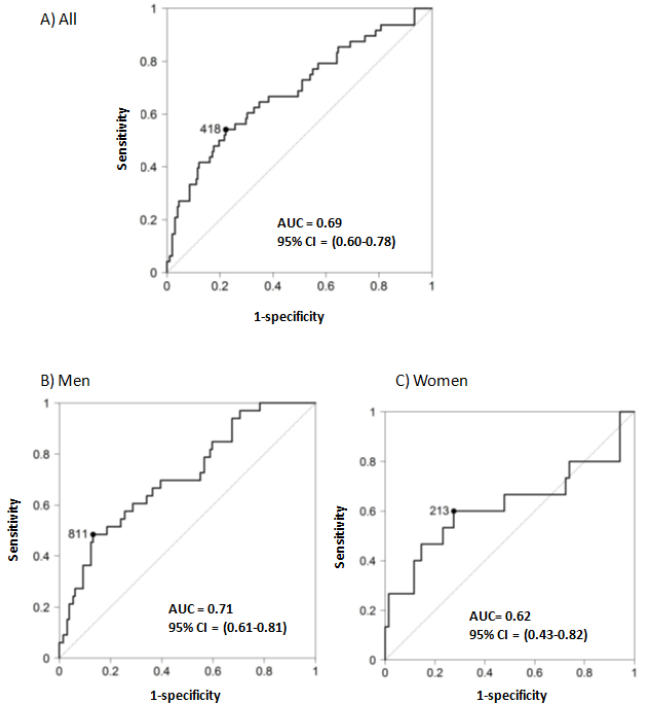
Figure 2. Receiver operating characteristic (ROC) for baseline UACR as a predictor of rapid progression. Area under the curve (AUC) of the receiver operating characteristic (ROC) for the prediction of rapid progression (defined as loss of eGFR > 5 mL/min/1.73 m 2 /year according to KDIGO 2012 [11] by baseline urinary albumin/creatinine ratio (UACR). ( A ) All patients. ( B ) Men. ( C ) Women, CI: confidence interval.